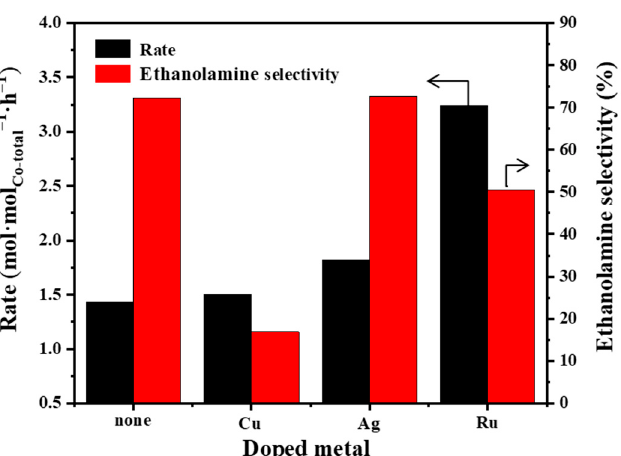
Figure 5. Effects of metal-doping on the rate and selectivity of the Co 98.5 M 1.5 / γ -Al 2 O 3 (M = Cu, Ag, and Ru; 5 wt% Co) catalysts in ammonolysis of ethylene glycol (453 K, 0.6 MPa NH 3 , 3.0 MPa H 2 , 0.067 mol/L ethylene glycol in tetrahydrofuran solution, controlled at ~20% conversion).